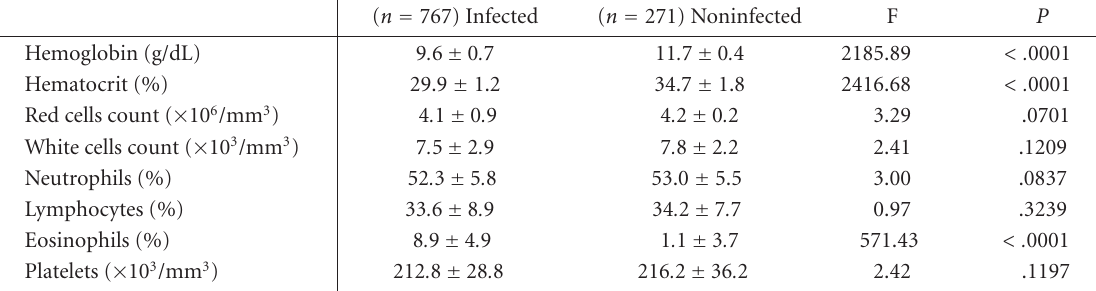
Table 3: Comparisons between levels of hematological laboratory variables in those women with or without intestinal parasitosis (mean ±